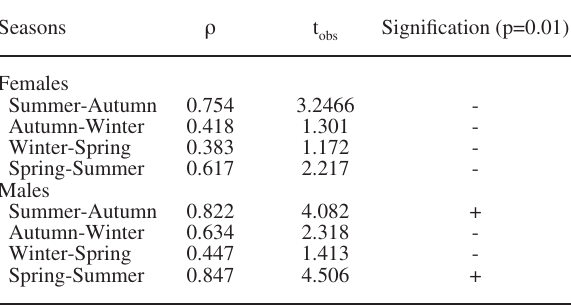
Table 9. – statistical comparaison of Pagellus acarne diet in rela- tion to sex; ρ , spearman coefficient of correlation; t values; (+), homogeneous diet; (-), heterogeneous diet.